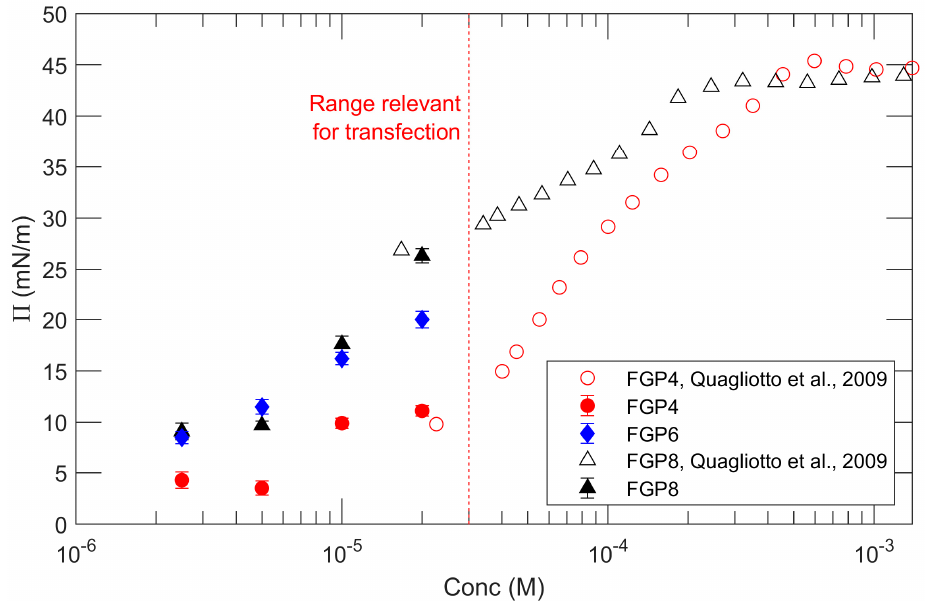
Figure 8. Variation of the surface pressure Π as a function of surfactant concentration in the bulk, after 2 h of incubation, for the 3 surfactant molecules studied (filled symbols); for FGP4 and FGP8, tensiometry data from ref. [16] have been included (empty symbols). Note the semilogarithmic scale. The vertical dashed line indicates the maximum concentration considered for the formation of non-viral gene delivery vectors.